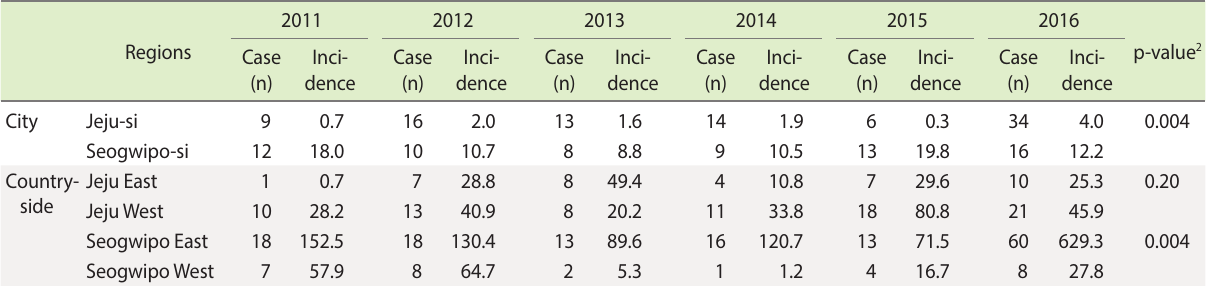
Table 1. Age-adjusted incidence rate 1 of scrub typhus per 100,000 by region in Jeju province Regions